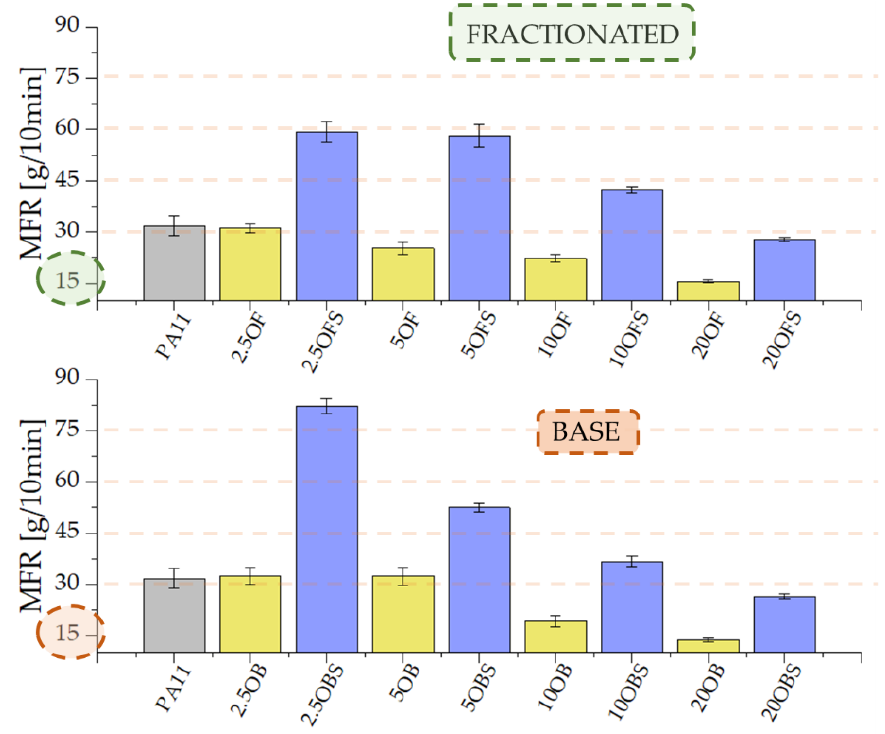
Figure 10. Melt flow rate (MFR) of the granulates of PA11/DE composites after injection moulding.